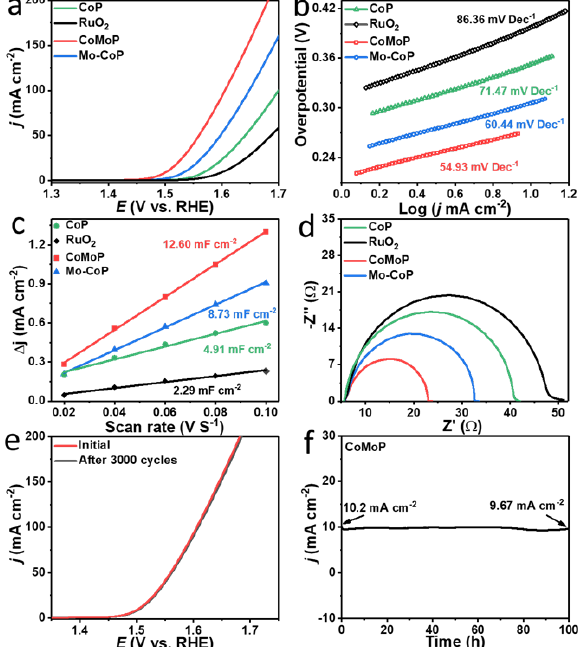
Figure 4. ( a ) OER polarization curves in 1.0 M KOH. ( b ) Corresponding Tafel plots. ( c ) Double-layer capacitances (C dl ). ( d ) Nyquist plots of the EIS data. ( e ) OER polarization curves before and after 3000 cycles. ( f ) OER chronoamperometric data for CoMoP at an overpotential of 273 mV.